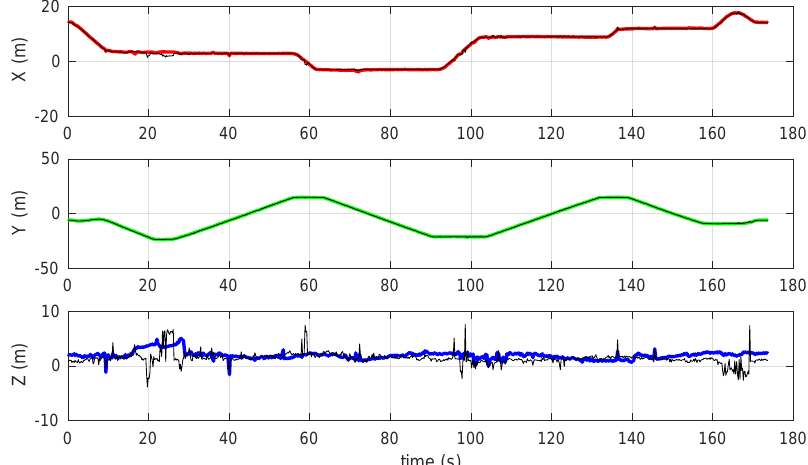
Figure 7. Coordinate vs. time profiles for the test measurement reported in Figure 5: manufacturer’s algorithm data are reported in